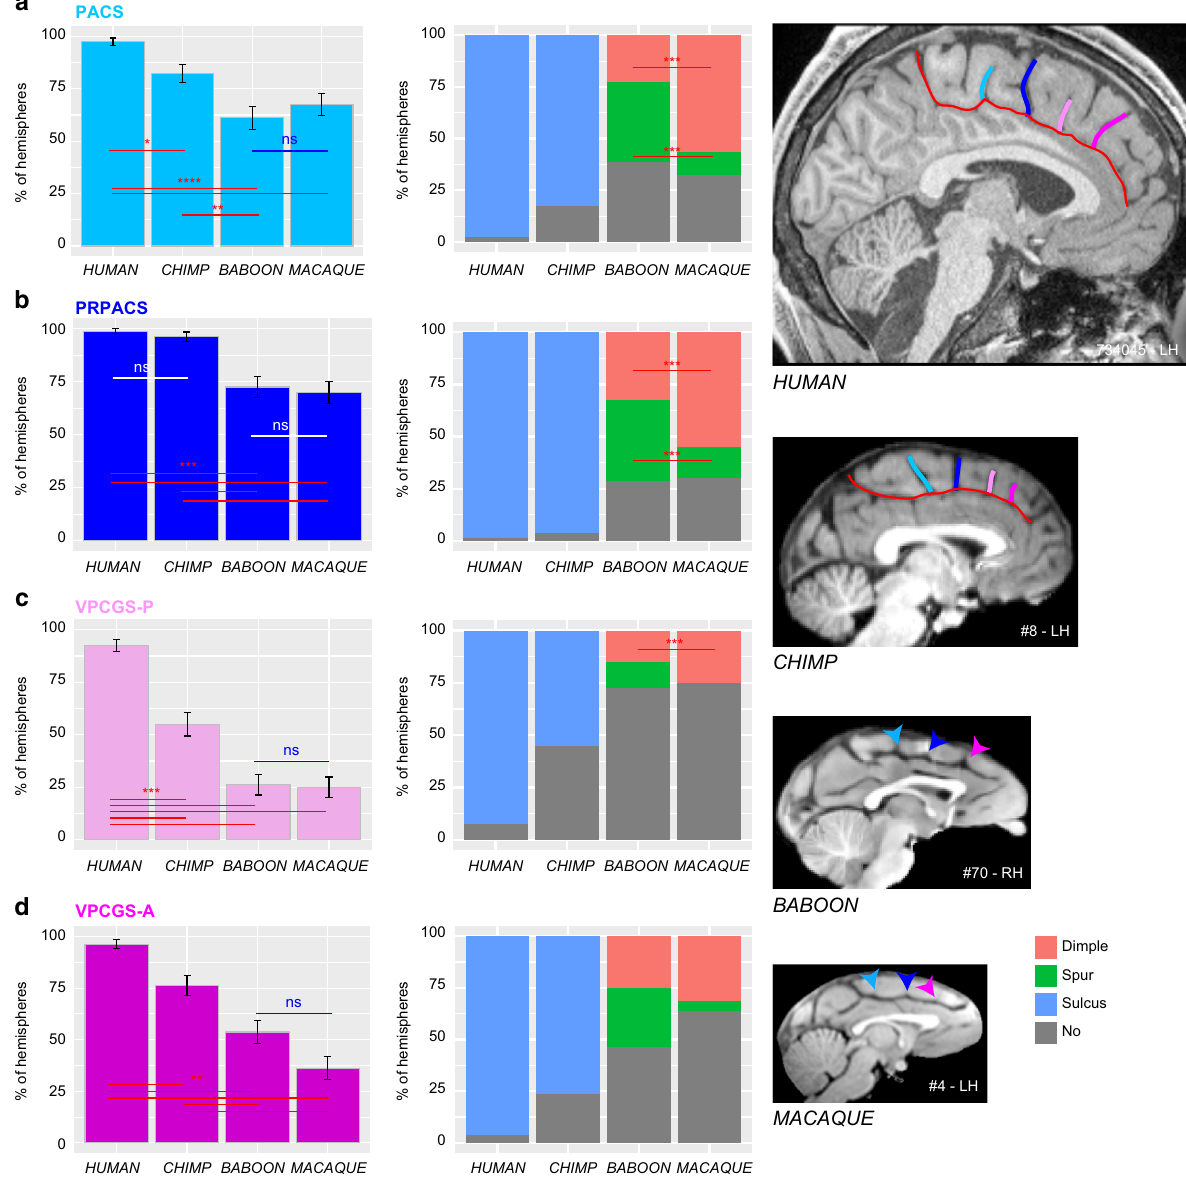
Fig. 4 Presence of vertical sulci in the dorsomedial frontal cortex across primates. Probability of occurrence (±s.e.m.) of the paracentral sulcus (PACS, a ), the pre-paracentral sulcus (PRPACS, b ), the posterior (VPCGS-P, c ) and the anterior (VPCGS-A, d ) vertical paracingulate sulci in the four species. a PACS. Left panel: The probability of observing a PACS decreases from human, chimpanzee, baboon, to macaque. Posthoc analysis showed that the presence of PACS was higher in Hominoidea (human and chimpanzee) than in Old-world monkeys (baboon and macaque), but that it was similar between human and chimpanzees and also between baboon and macaque. Right panel: PACS characteristics vary across primates: it is a sulcus (blue) in 100% of hemispheres in Hominoidea, it is a spur (green) or a dimple (pink) in Old-world monkeys. It is more frequently a spur than a dimple in baboon, as opposed to macaque. b PRPACS. Left panel: the probability of observing PACS is higher in Hominoidea than in Old-world monkeys but is similar between human and chimpanzee, on one hand, and between baboon and macaque on the other hand. Right panel: PRPACS characteristics vary across primates: it is a sulcus in 100% of hemispheres in Hominoidea, but it is a spur or a dimple in Old-world monkeys. It is more frequently a spur than a dimple in baboon, as opposed to macaque. c VPCGS-P. Left panel: the probability of observing VPCGS-P decreases from human, chimpanzee, baboon, to macaque. Posthoc analysis demonstrated that the presence of the VPCGS-P was higher in human than in non-human primates. Its probability of occurrence was also higher in chimpanzee than in Old-world monkeys. It was, however, similar between macaque and baboon. Right panel: VPCGS-P characteristics vary across primates: it is a sulcus in 100% of hemispheres in Hominoidea, but it is a spur or a dimple in baboon and only a dimple in Macaque. d VPCGS-A. Left panel: The probability of occurrence of VPCGS-A decreases from human, chimpanzee, baboon, to macaque. Right panel: VPCGS-P characteristics vary across primates: it is a sulcus in 100% of hemispheres in Hominoidea, but it is more frequently a spur than a dimple in baboon, as compared with